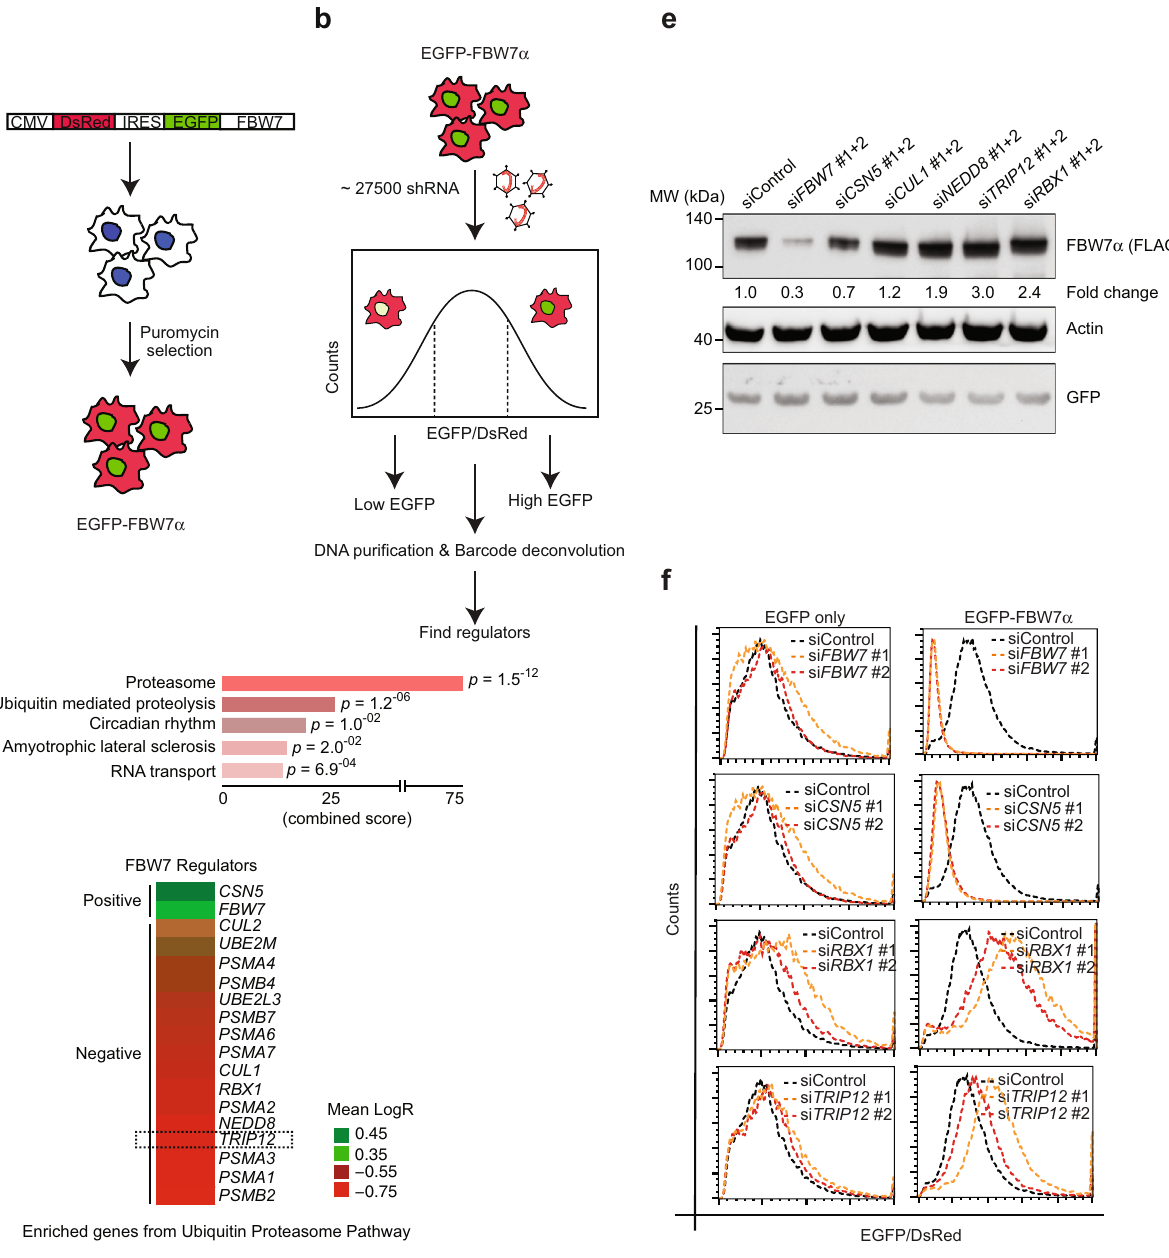
Fig. 1 A shRNA library screen identi fi es post-translational regulators of FBW7 stability. a Schematic of DsRed-IRES-EGFP-FBW7 α vector and creation of stable HEK293T cell line. b Schematic of pooled shRNA library EGFP-FBW7 α stability screen. c Pathway analysis of enriched hits showing “ Proteasome ” and “ Ubiquitin-mediated proteolysis ” as top enriched gene sets in the screen. Statistics were done by Fisher ’ s exact t -test and adjusted for multiple comparisons. d Heat map showing mean logR enrichment values for the shRNAs of each gene from the ubiquitin-proteasome pathway. e Western blot validation of selected hits from d in HEK293T cells. Numbers represent quanti fi cation of FLAG-FBW7 band normalised to GFP loading control and are shown as fold change. The experiment was repeated at least three times with similar results. f Flow cytometry validation of two positive and two negative regulators of FBW7 protein stability shown as EGFP-FBW7/DsRed ratio, n = 3 independent experiments. See also Supplementary Fig. 1. Source data are provided as a Source Data fi